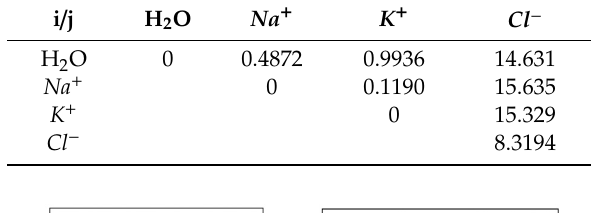
of UNIQUAC model [16,23]. ji